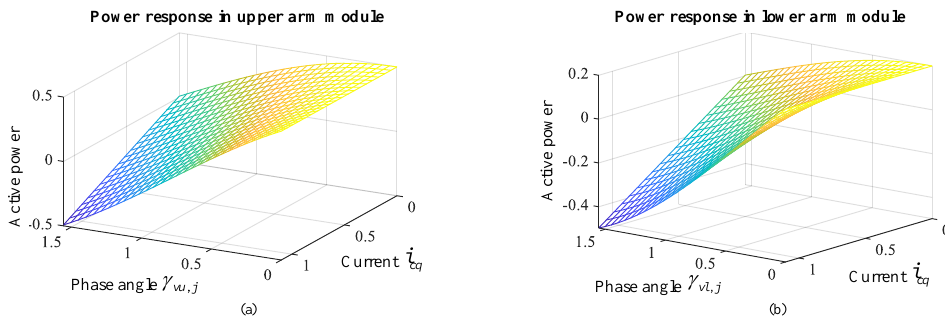
Figure 6. Active power compensation under circulating current and phase-angle variations with a 40% power difference between both arms. ( a ) Module in the upper arm, ( b ) module in the lower arm. The concept behind the QVC can be studied using the vector representation shown in Figure 7. The diagram evaluates the interaction of three modules in balanced and imbalanced operation. In balanced operation, all modules generate the same power with output voltages equal to v id ,1 , v id ,2 , and v id ,3 . The combination of these voltages defines the voltage v o modulated at the AC terminals. Note that the current arm i i has a phase angle of γ i degrees.